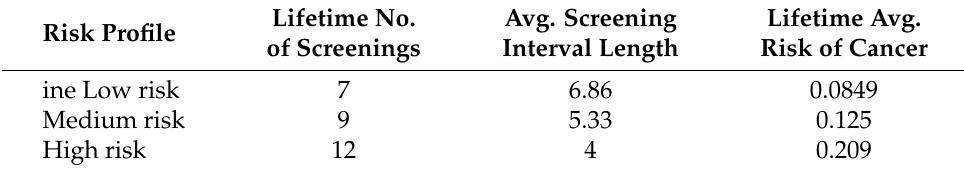
Figure 5. Five-year average risk of cancer for patients with different risk profiles. Colored dots show the screening ages of each risk profile. Table 2. Impact of the patient’s risk profile on the cancer risk and screening